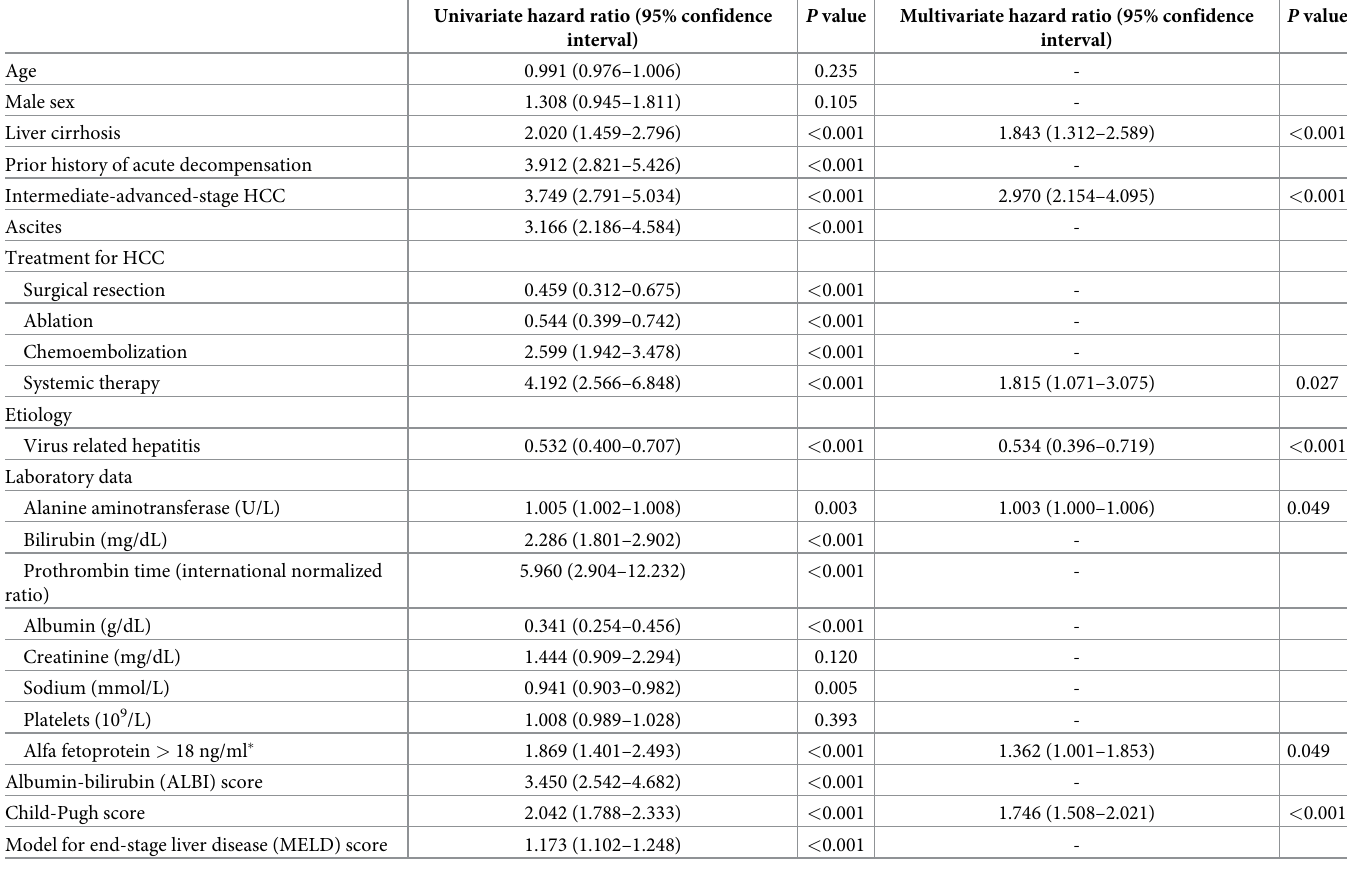
Table 2. Cox regression analyses of predictive factors for the development of acute